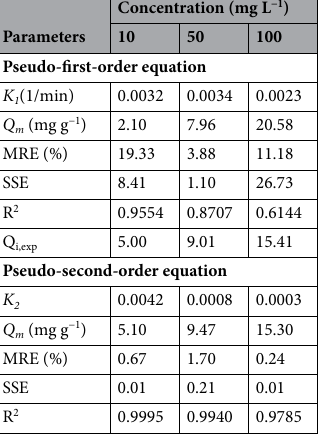
Table 1. The pseudo-first-order and pseudo-second-order equations parameters of BMBC adsorption of Cr(VI). Q i,exp is represent adsorption capacity from experiment.